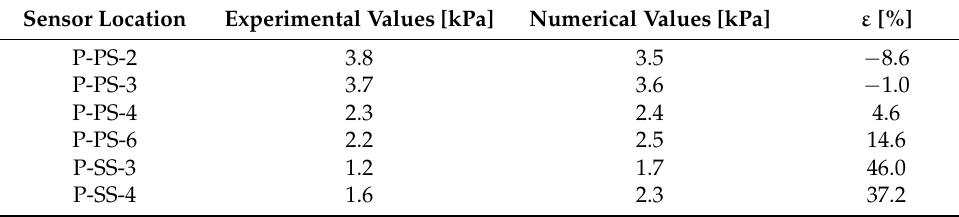
Figure 7. Scaled mean absolute pressure values. Table 4. Scaled mean absolute pressure